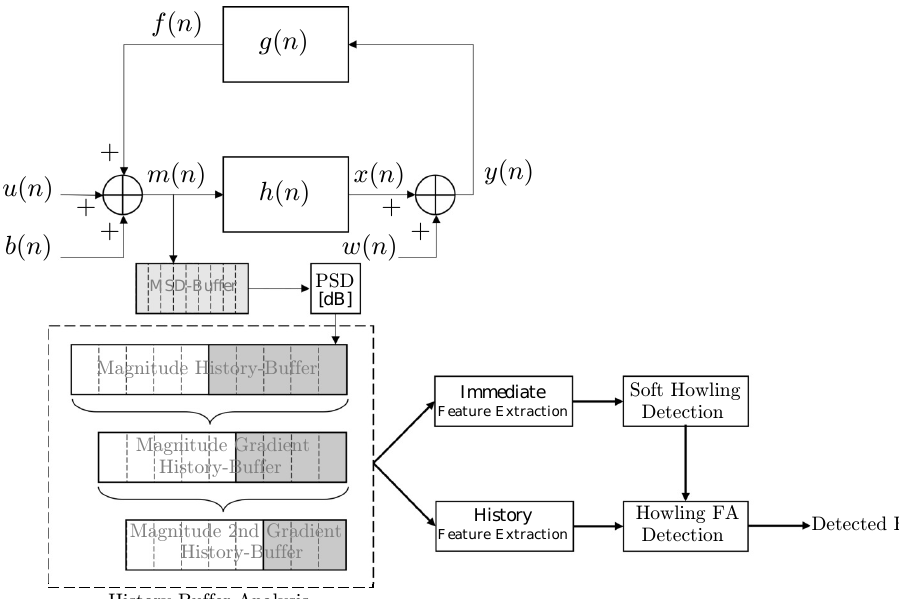
Figure 3. Proposed Magnitude-Slope-Deviation (MSD)-based howling detection algorithm within the in-room SR system. Each frame of the Magnitude History Buffer contains the frequency component magnitudes of the microphone signal, determined by the Power-Spectral-Density (PSD) on the microphone signal samples, stored in the MSD-buffer. The recent frames of the Magnitude History Buffer are referred to as the detection-buffer, and the entire buffer as the history-buffer. Accordingly, the Soft Howling Detection stage evaluates the detection-buffer, and the subsequent Howling False- Alarm (FA) Detection stage evaluates the history-buffer at the suspected frequency bins, to refute the false-positive howling